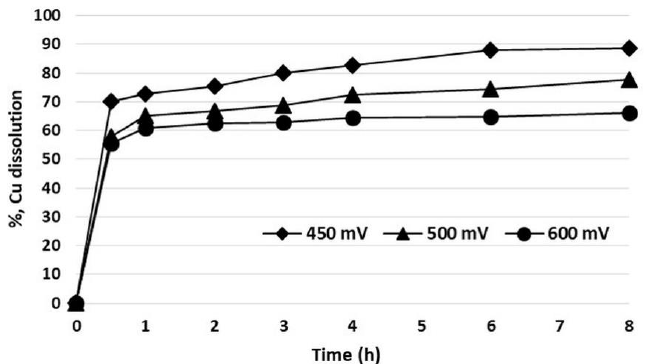
Figure 9. EDS analysis associated with Figure 8. Particles identified: limonite (1) and chrysocolla (2).